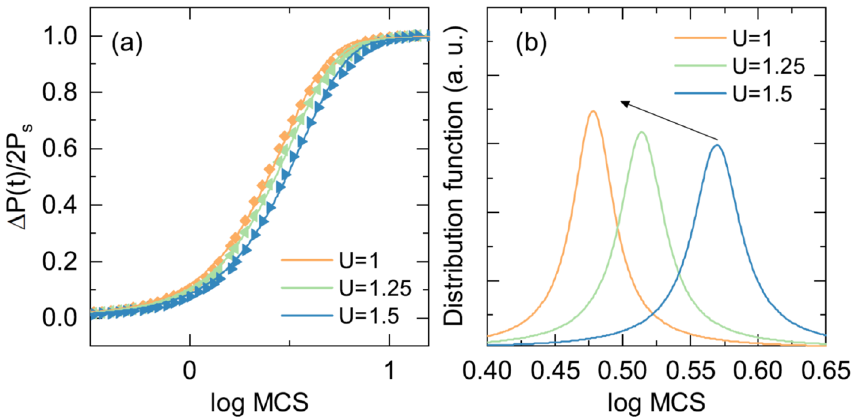
Figure 6. Monte Carlo simulations of the ferroelectric switching dynamics for different activation energy barrier heights. ( a ) Polarization reversal behavior and fitting line for different activation energy barriers. ( b ) Fitted Lorentzian distribution function for different activation energy